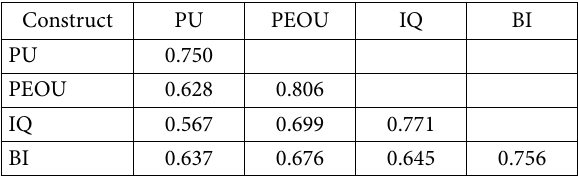
Table 7. Inter-item correlations (square roots of AVE in diagonals) Construct